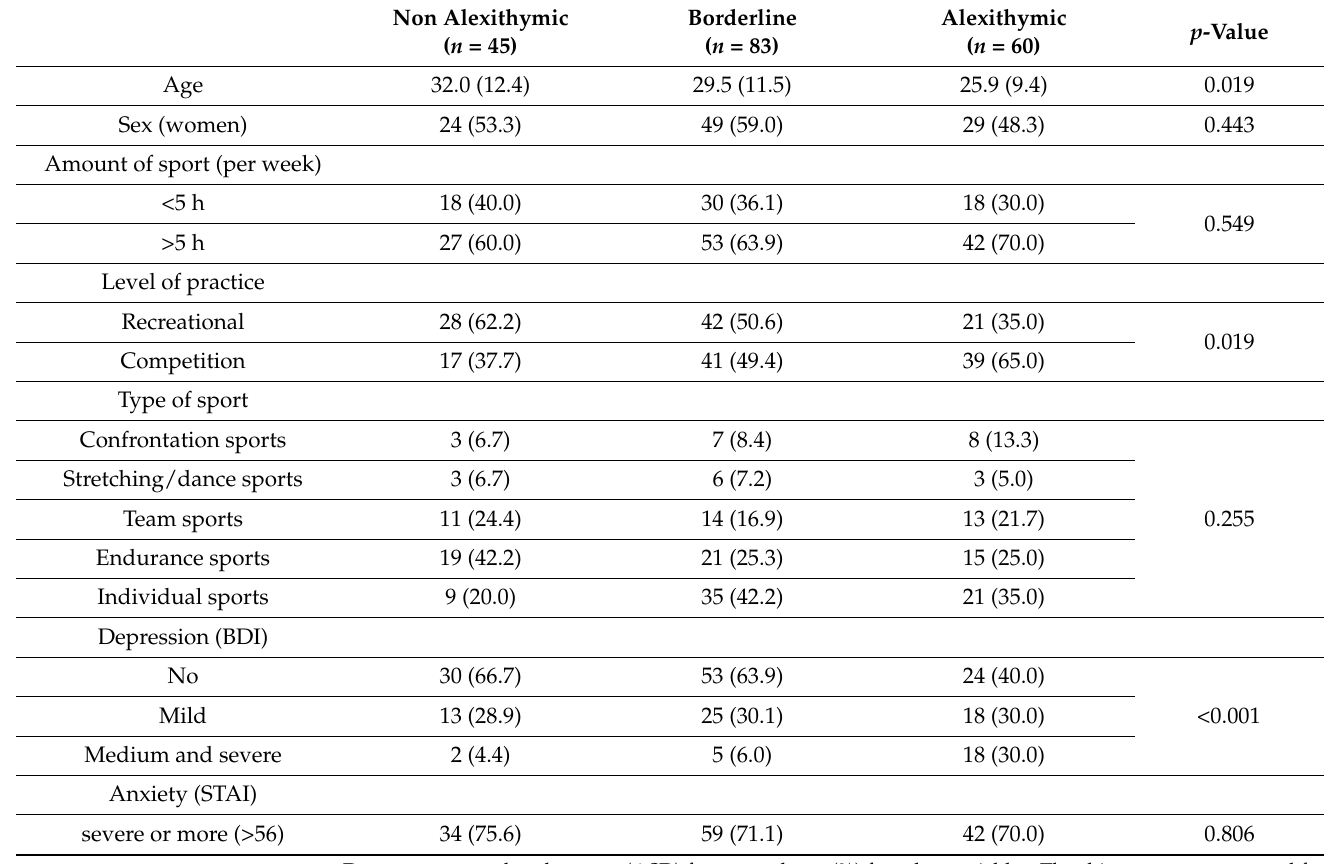
Table 2. Relationships between alexithymic participants and depression, anxiety, sport